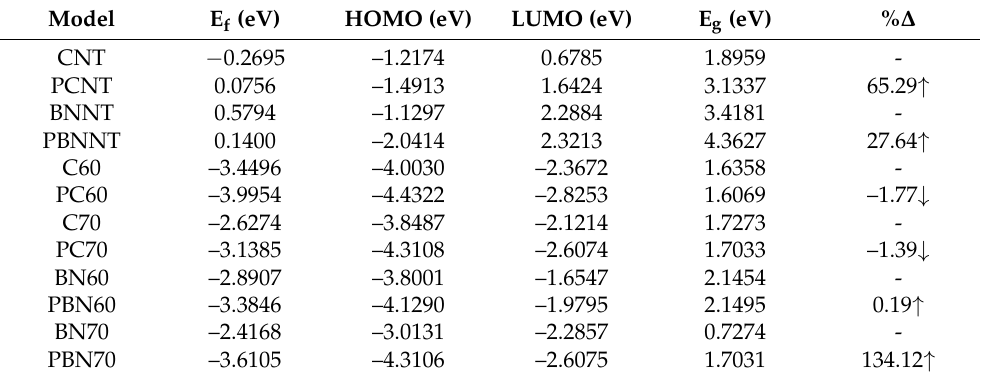
Table 2. Changes in bandgap after phosgene-adsorbent interaction. Changes in bandgap after phosgene-adsorbent interaction. E f is the Fermi energy and the corresponding percentage change (% ∆ ) in the bandgap after